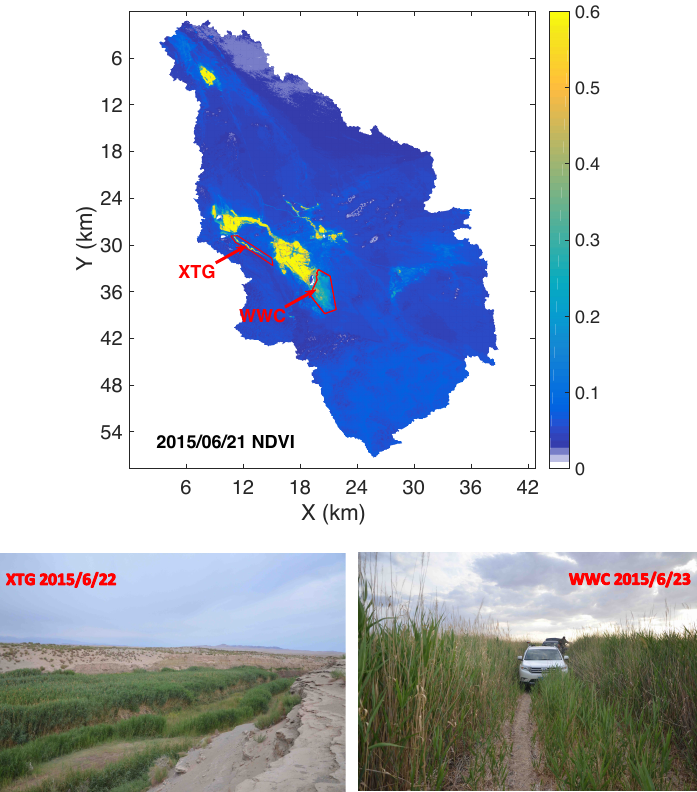
Figure 8. The NDVI on 21 June 2015 computed from the Landsat 8 OLI near infrared and red band images. The red arrows point to the typical wetland vegetation pixels in the XTG and WWC on the NDVI image ( top ). Two pictures ( bottom ) showing the wetland vegetation and the landscape of these two pixels that were taken during the field survey on 22–23 June 2015.